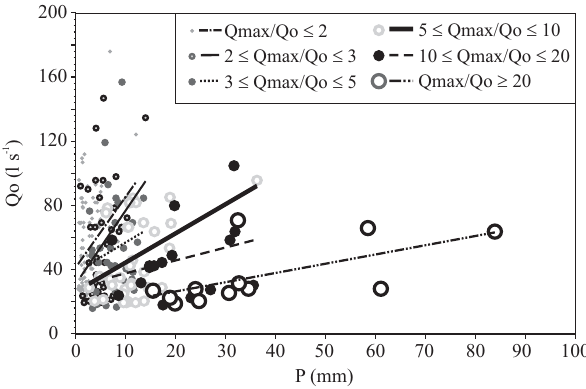
Fig. 6. Event precipitation, recorded at the gauging station, (mm) needed to produce an increase in the initial discharge ( Q o , Ls − 1 ) . Grey spots represent discharge increase expressed as the ratio Q max / Q o . Size of the spot corresponds to discharge-raising magnitude. Black lines represent relationships for events where the ratio Q max / Q o is similar.